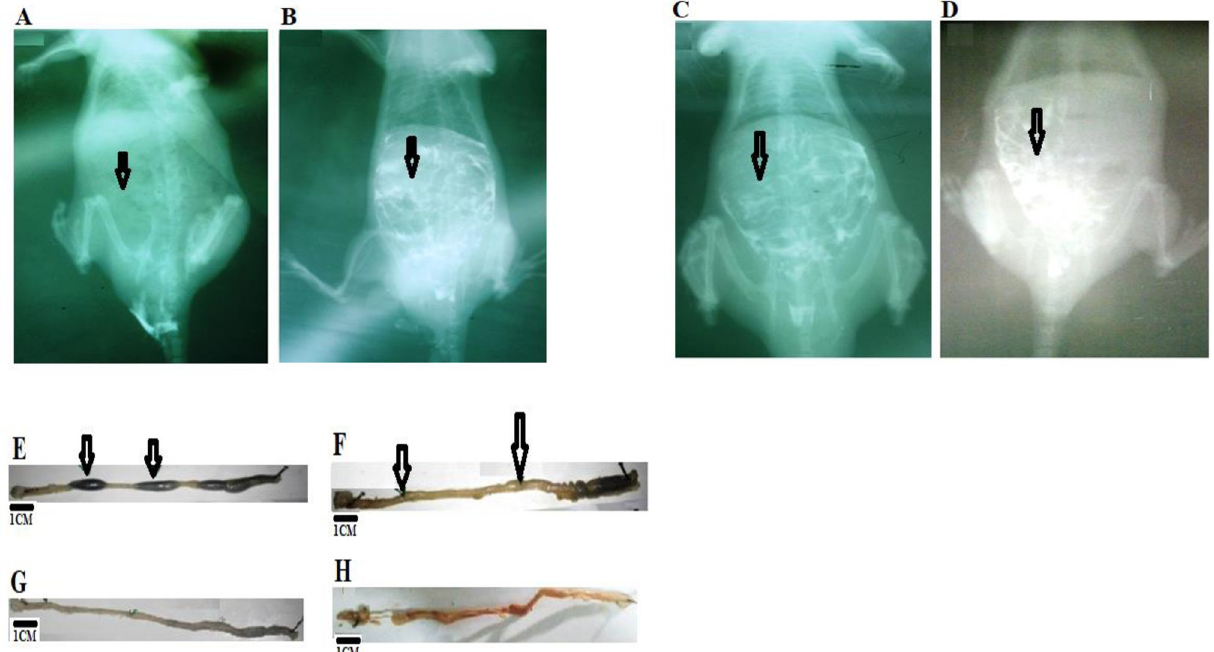
Fig 4. Double contrast barium enema and grossed appearance of the colon and rectum post and pre-treatment in rats. A) Apparently normal colon lesion showing free uptake of the barium. B and C) Tumour involvement was evident by diffuse uptake of the barium at the anterior portion of the colon and little uptake at the mid to caudal portion. This signifies tumour involvement. D) Disarrayed uptake of the barium post-aspirin plus FOLFOX treatment. E, Grossed section of apparently normal colorectal lesions with arrows pointing to areas occluded by faecal materials. F) Tumour-bearing colorectal lesions Pre aspirin plus FOLFOX treatment with arrows showing areas with tumour involvement and total absent of faecal material. G) Tumour-bearing colorectal lesion post-treatment with aspirin plus FOLFOX in sequence showing apparently normal areas. H) Tumour-bearing colorectal lesion post-concurrent treatment with aspirin plus FOLFOX showing irregular distorted architecture of the colon and rectum with haemorrhagic areas.